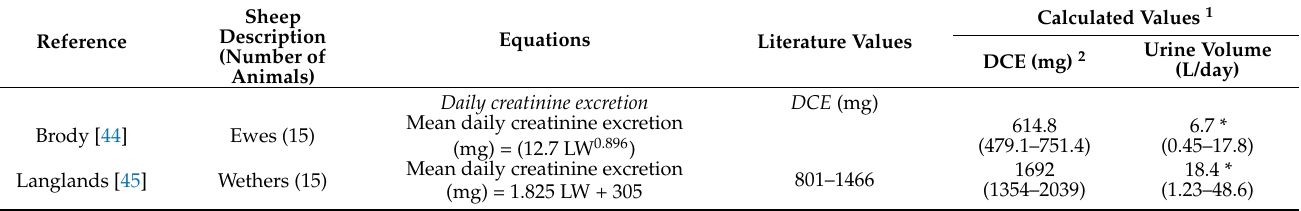
Table 3. Published equations for predicting daily creatinine excretion (DCE; mg) and urine volume (L/day), including their published ranges (min and max) and calculated DCE values and urine volume using data collected over two years in the authors’ study [41] based on these equations (average, min and max in